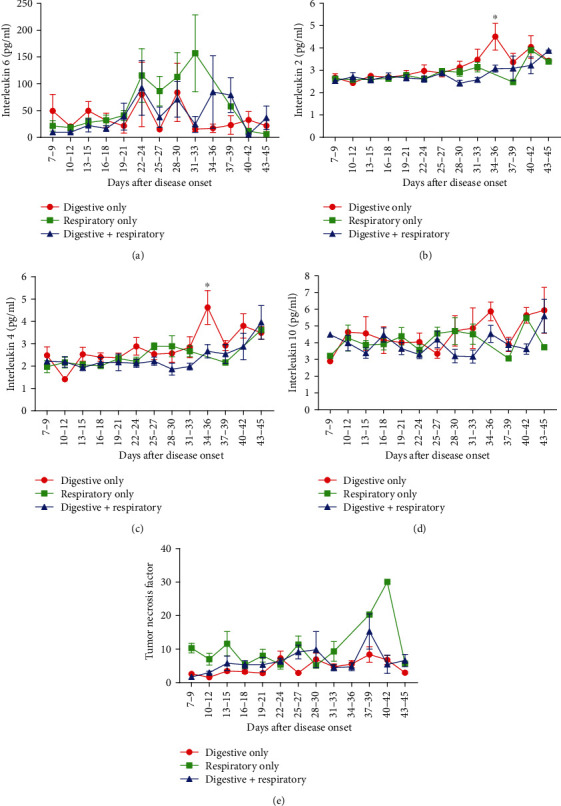
Dynamic profile of peripheral cytokine levels in COVID-19 patients with different symptoms. Timeline charts illustrate the peripheral IL-6 (a), IL-2 (b), IL-4 (c), IL-10 (d), and TNF-α (e). Error bars, mean ± SEM; ∗P < 0.05, Digestive Only vs. Digestive+Respiratory.